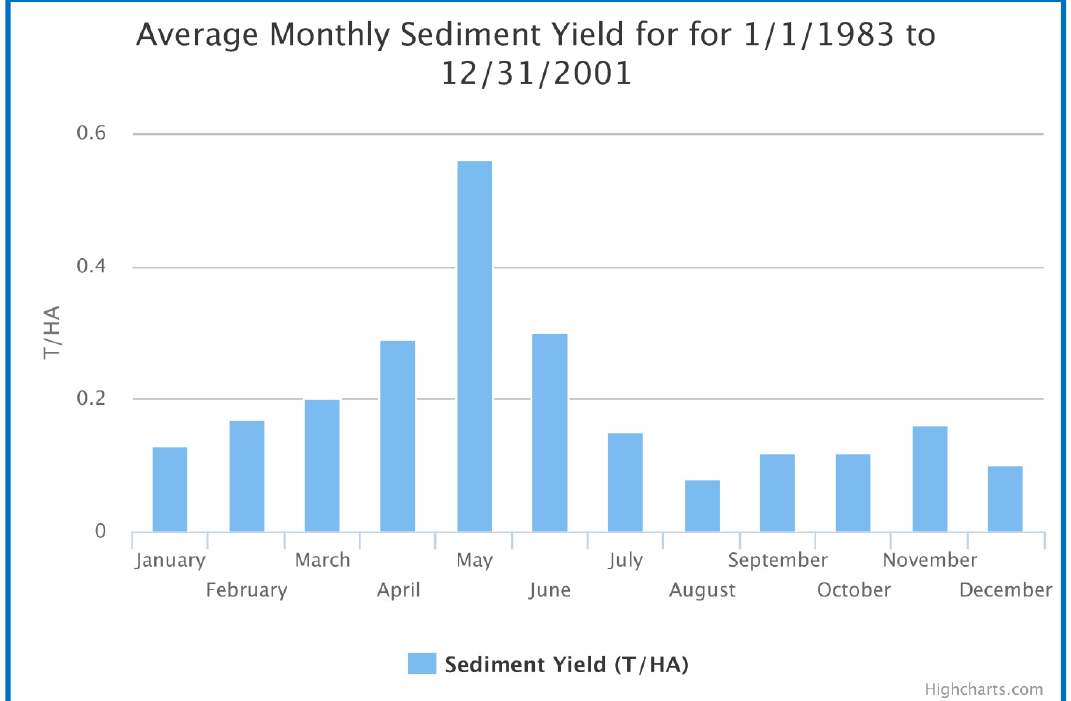
Figure 12. Average monthly sediment yield for the Illinois River Basin.